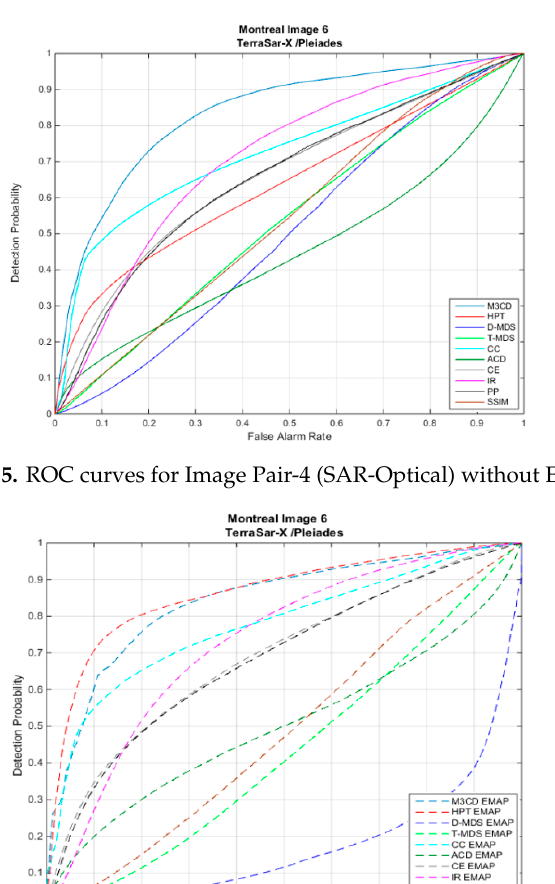
Figure 16. ROC curves for Image Pair-4 (SAR-Optical) with EMAP.